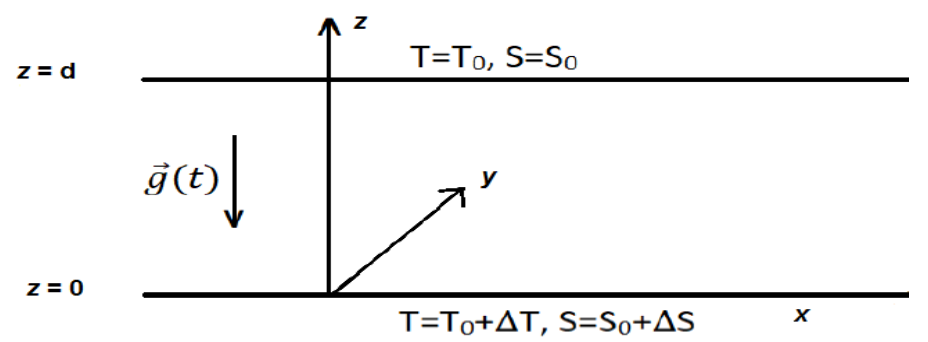
Figure 1. Schematic of the problem.